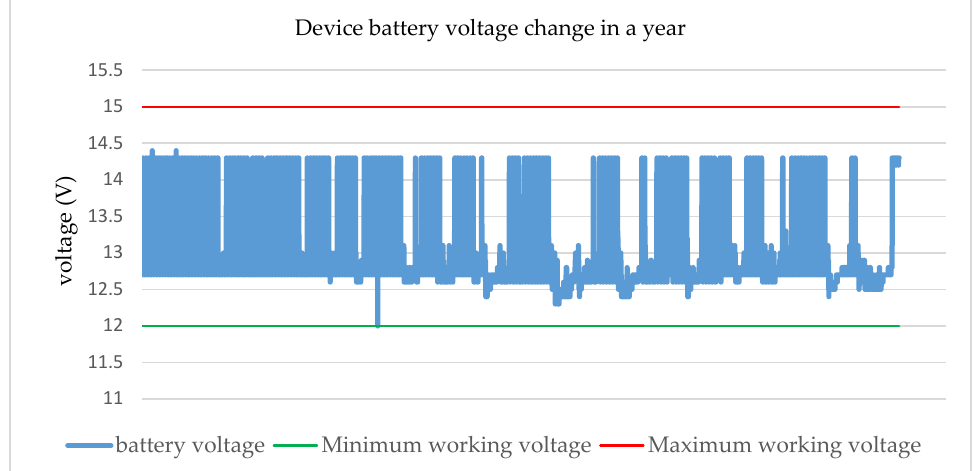
Figure 11. The battery voltage change trend of the device in a year. It shows that the battery voltage (the blue line) was always maintained between the maximum (the red line) and the minimum working voltage (the green line), and the solar-based power supply ensured that the equipment was working properly.